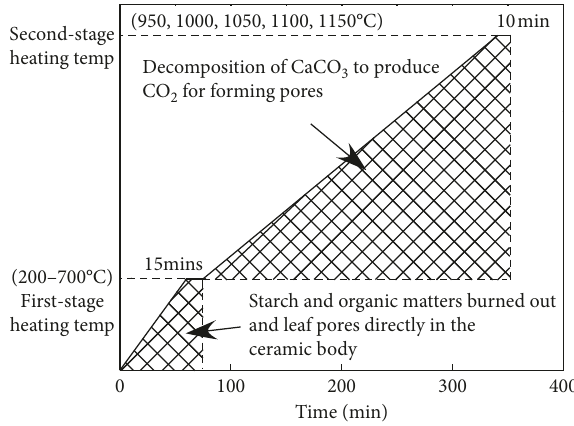
Figure 14: The schedule for preparing porous ceramics from fly ash/municipal